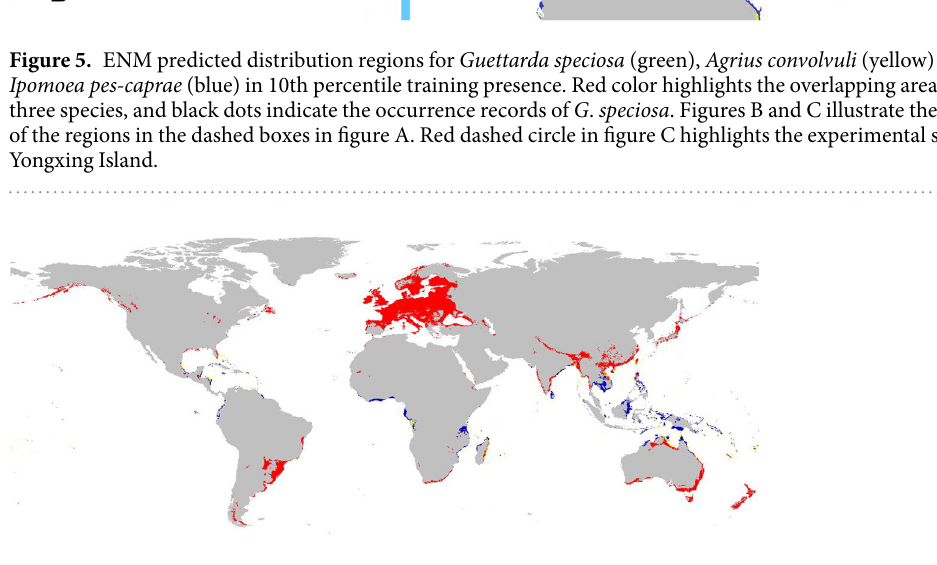
Figure 6. Suitable range for Agrius convolvuli (Red), Guettarda speciosa (Blue), overlapping regions (Yellow) in 10 th percentile training